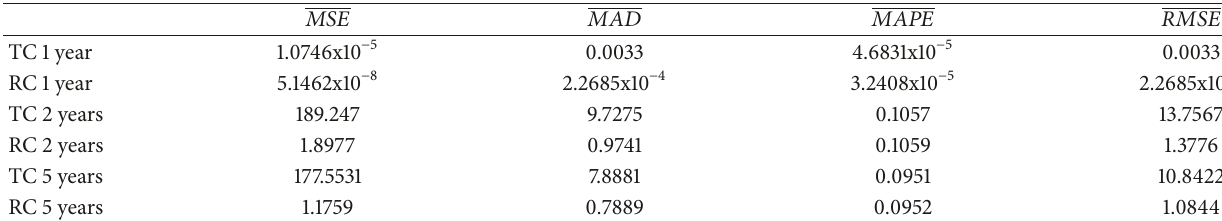
Table 13: LES error measures for different steps-ahead